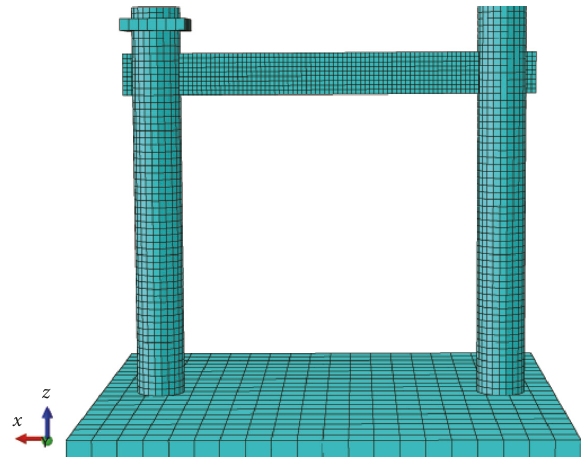
Figure 14: FEM model of wood frame.